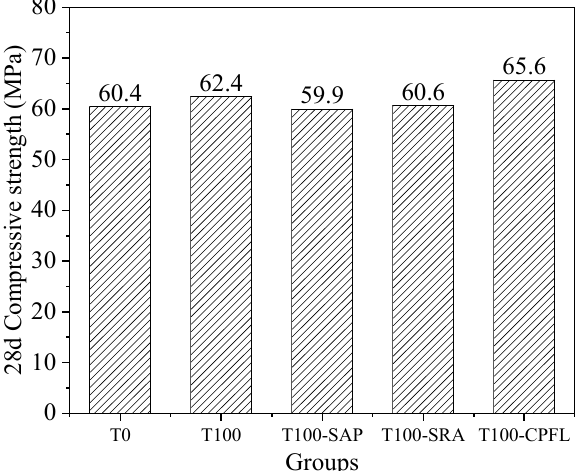
Figure 12. Effects of shrinkage-reducing methods on 28 d compressive strength of iron tailings sand concrete.